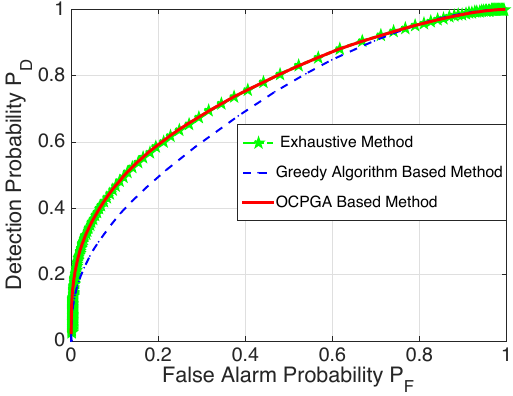
Figure 2. ROC curve for the small-scale case.